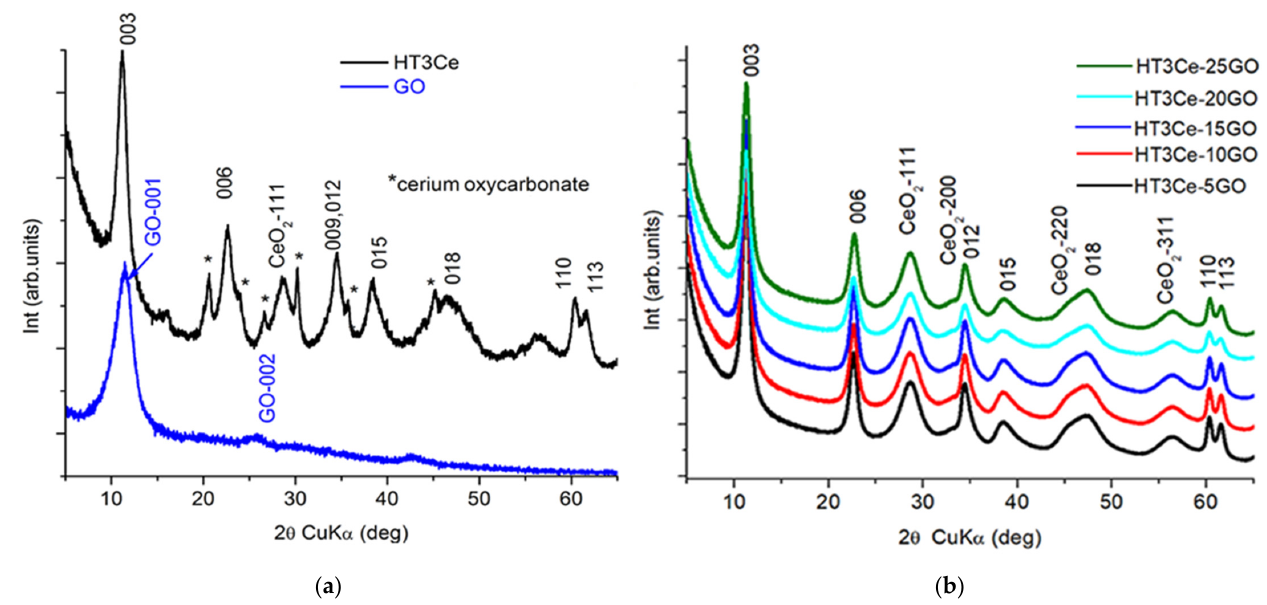
Figure 2. XRD patterns of: ( a ) HT3Ce and GO; ( b ) the composite samples. Table 3. Crystal unit cell parameters of the synthesized samples.